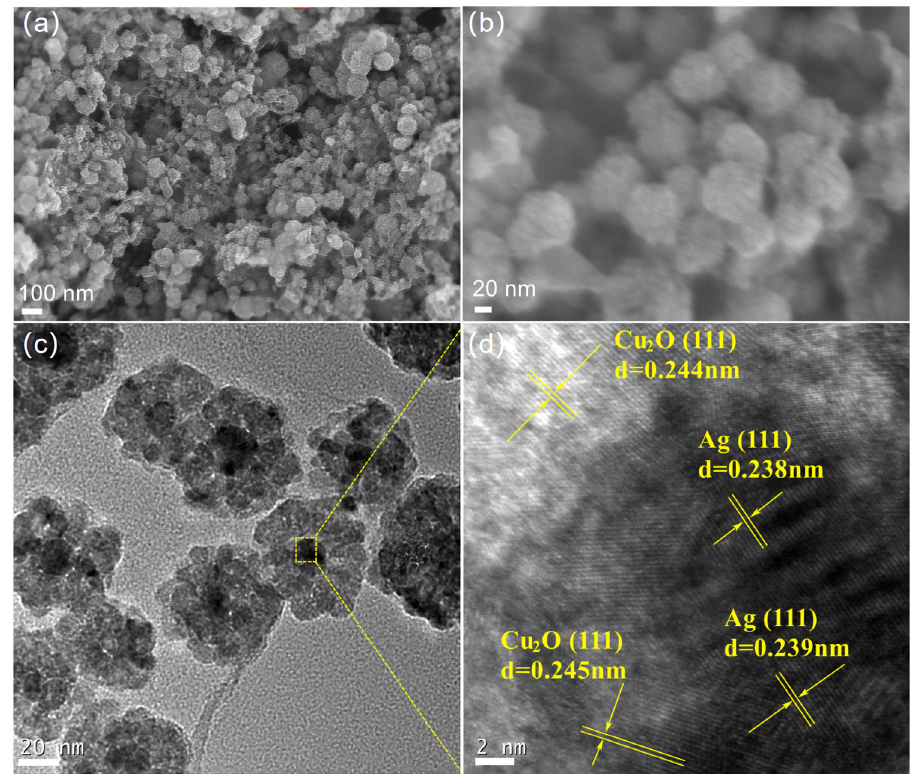
Figure 1: ( a and b ) SEM and ( c and d ) TEM images of Cu 2 O/Ag - rGO